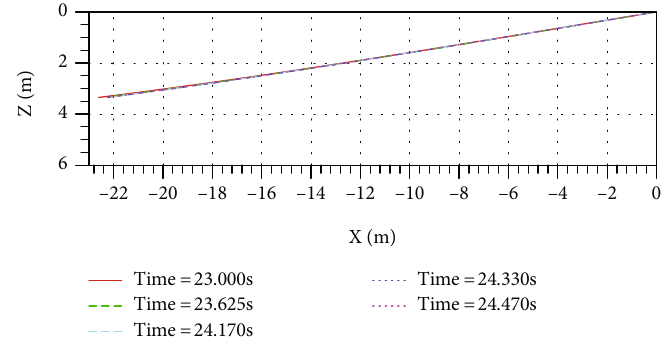
Figure 11: Case W2E0-k100 hose geometry